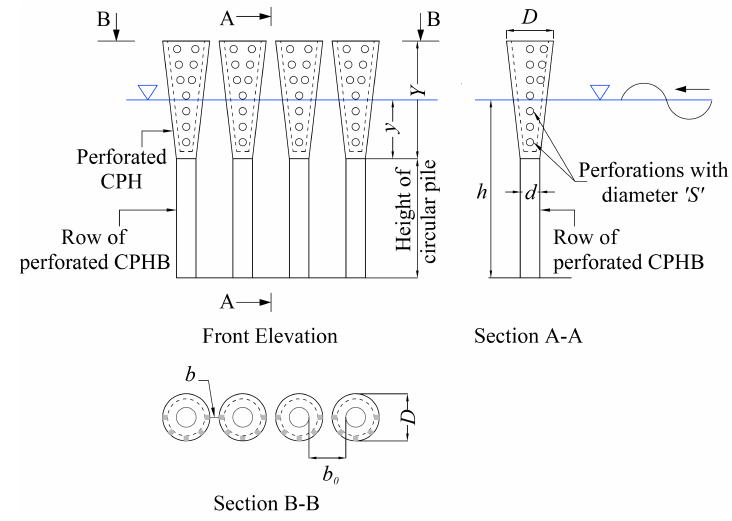
Figure 1. Schematic representation of the proposed CPHB